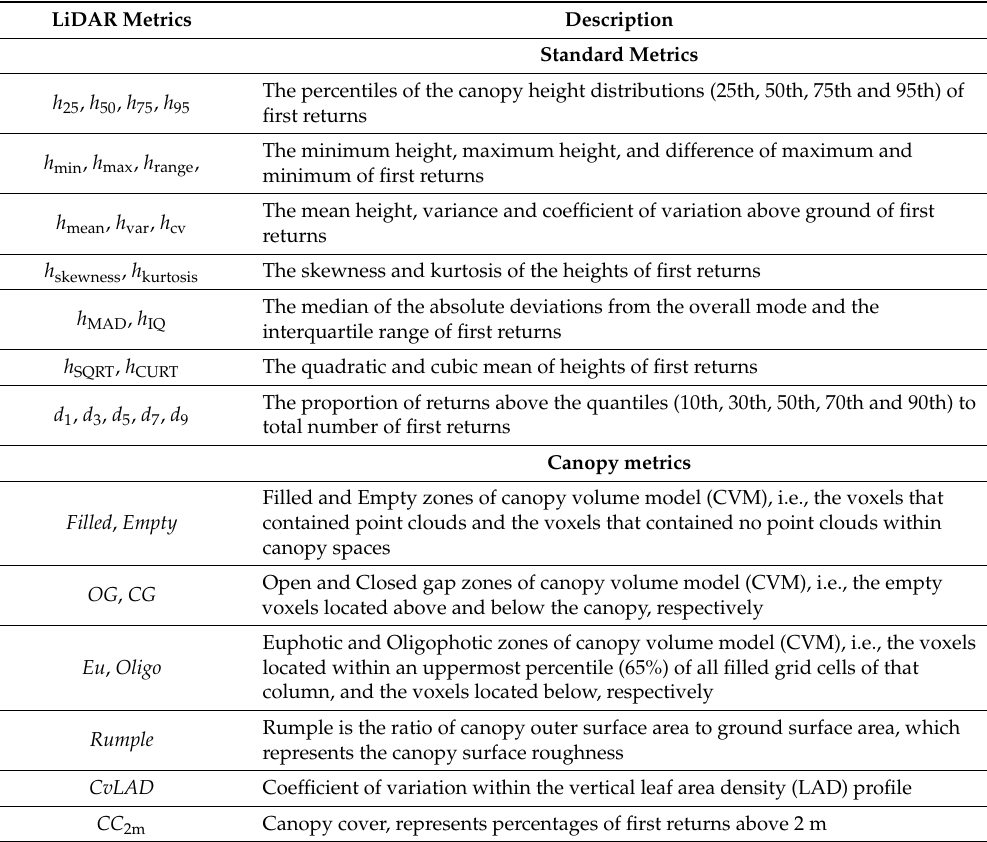
Table A3. Summary of LiDAR metrics used for fitting models in this